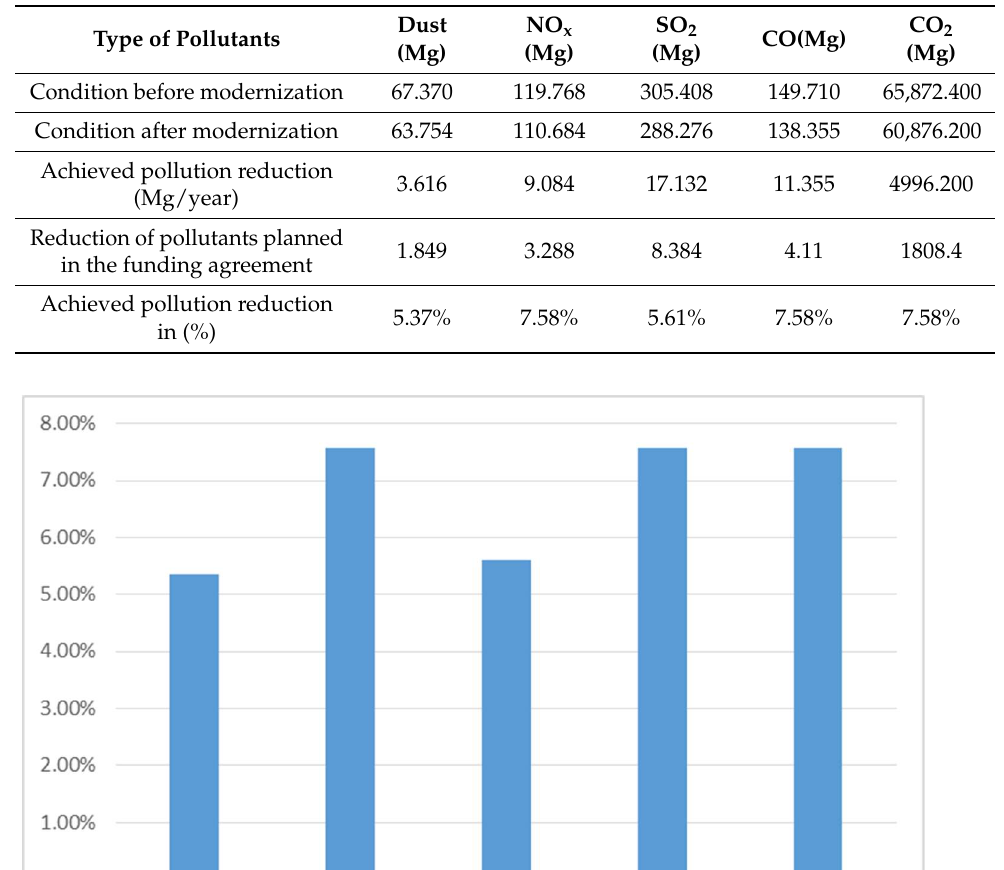
Table 2. Reduction in pollutants achieved by modernization of WR type boiler.